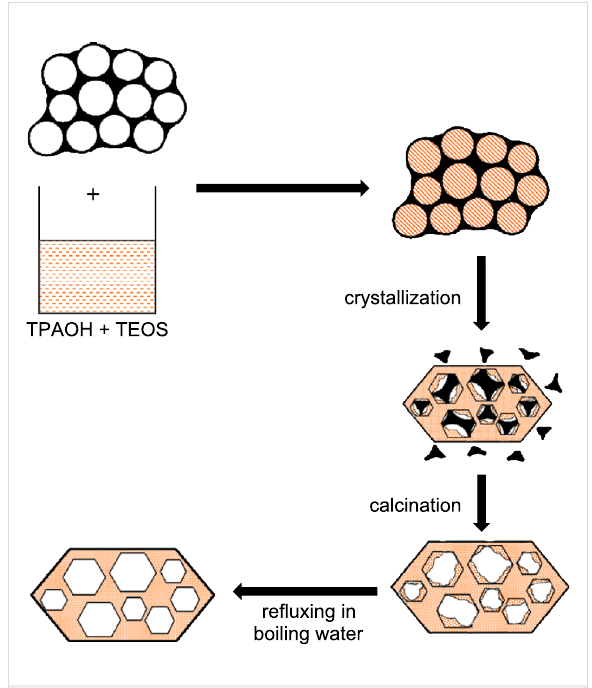
Figure 5: Schematic representation of the carbon-based hard- templating route for the formation of mesoporous silicalite-1 (MFI) zeolite. In the first step, the zeolite precursor solution is combined with a mesoporous carbon template (= black matrix). Then the zeolite is crystallized and the crystals entirely or partially encapsulate the porous carbon. In addition, amorphous silica is also formed. The carbon matrix is removed by calcination. Finally, the amorphous silica is dissolved by refluxing the material in boiling water, resulting in the formation of mesoporous silicalite-1. Reprinted from [98]. Copyright 2007, with permission from Elsevier.